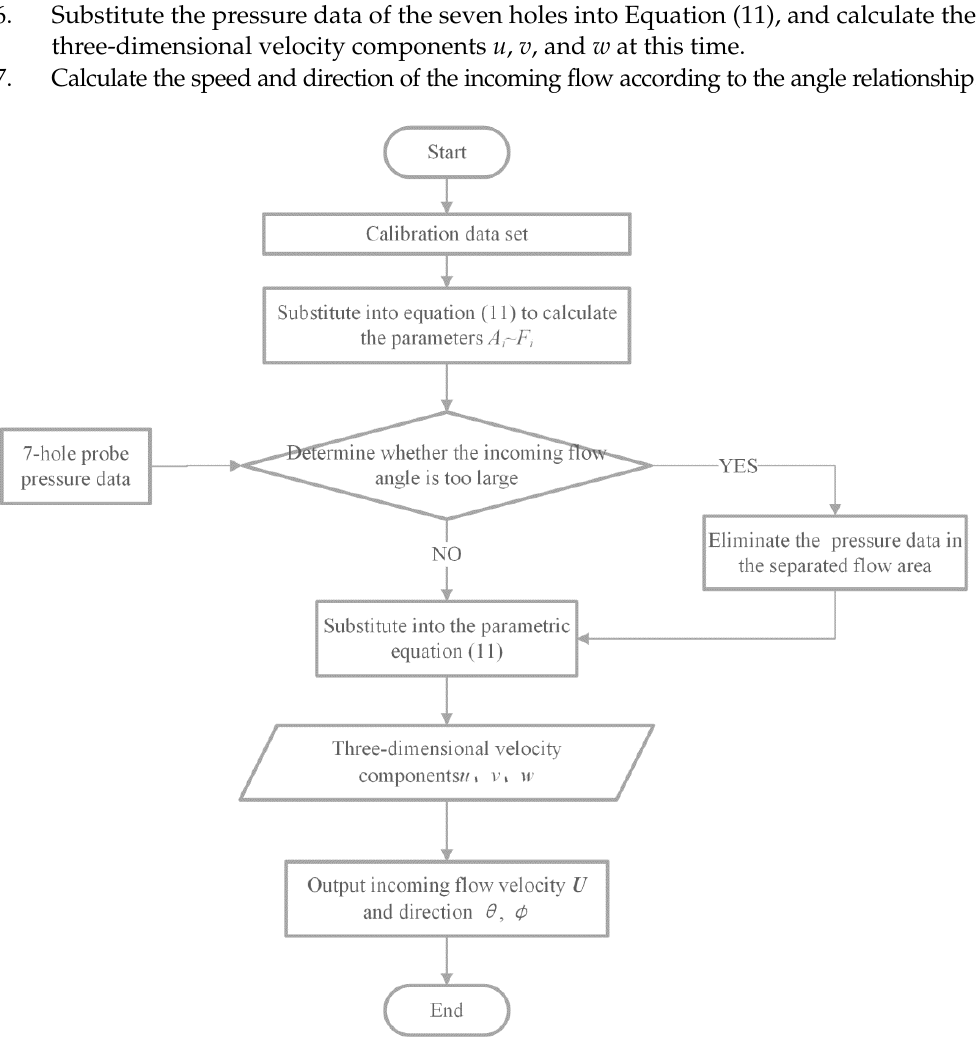
Figure 6. Flowchart of probe calibration and measurement.